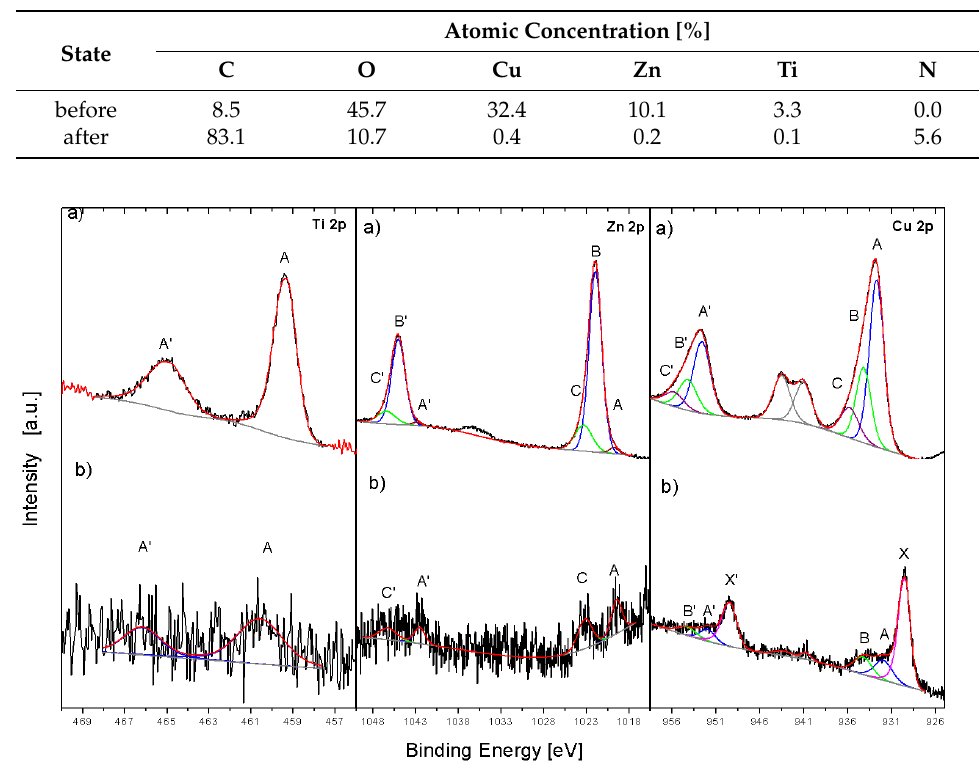
Figure 3. XPS analysis of the filler before ( a ) and after ( b ) interaction with PA12. The comparison of Cu 2p, Zn 2p and Ti 2p